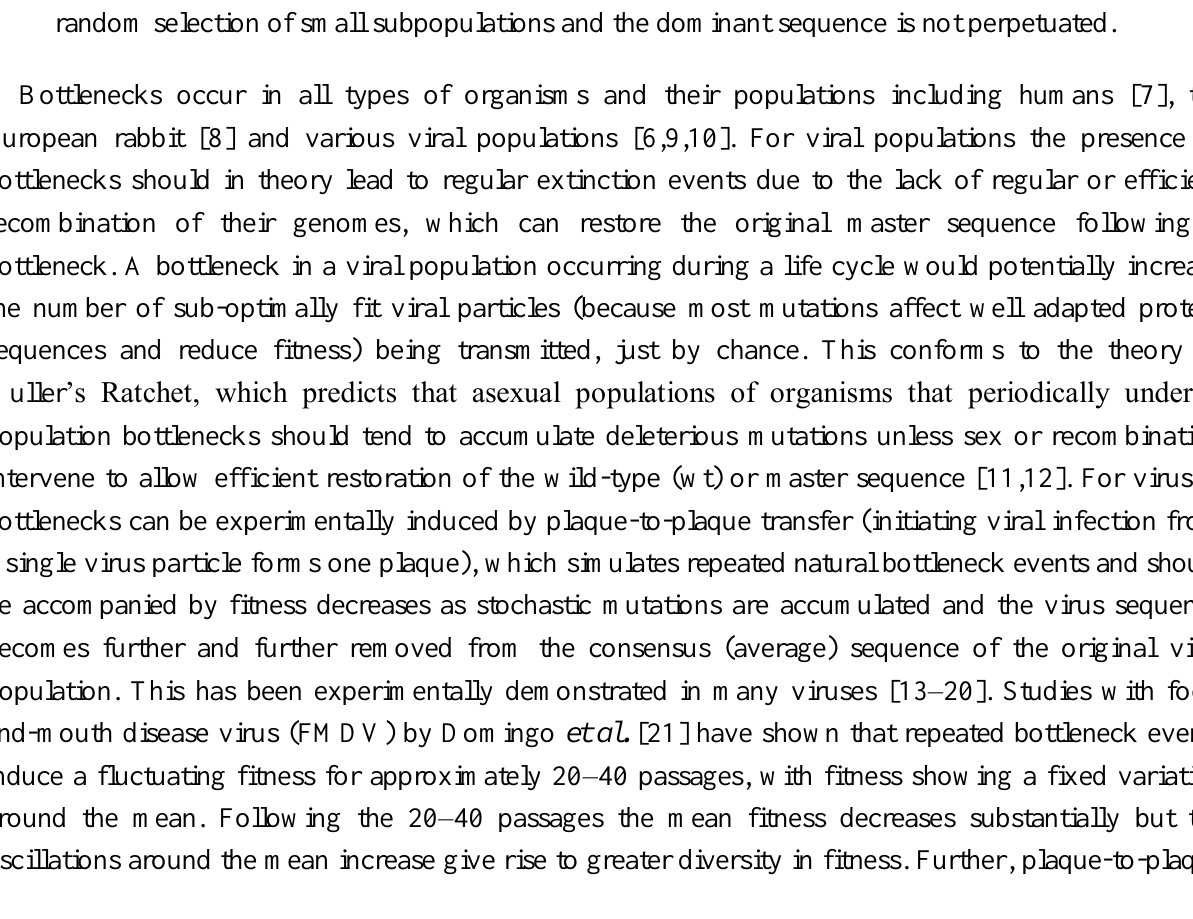
Figure 1. Effects of a bottleneck on virus populations, where virus variants are shown as colored circles: (1) Only the largest subpopulation is maintained after the bottleneck and viral variation decreases; (2) Virus variability decreases but a small amount of viral diversity is retained, and (3) Virus population diversity changes significantly due to random selection of small subpopulations and the dominant sequence is not